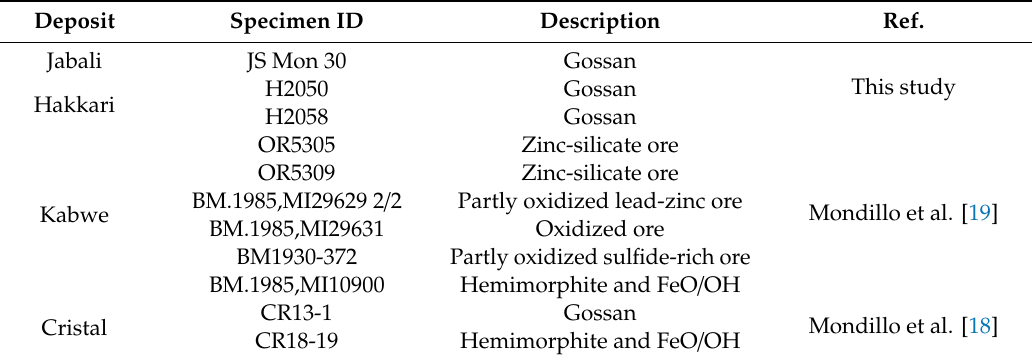
Table 1. Specimens used for this study (NHM and DiSTAR ore